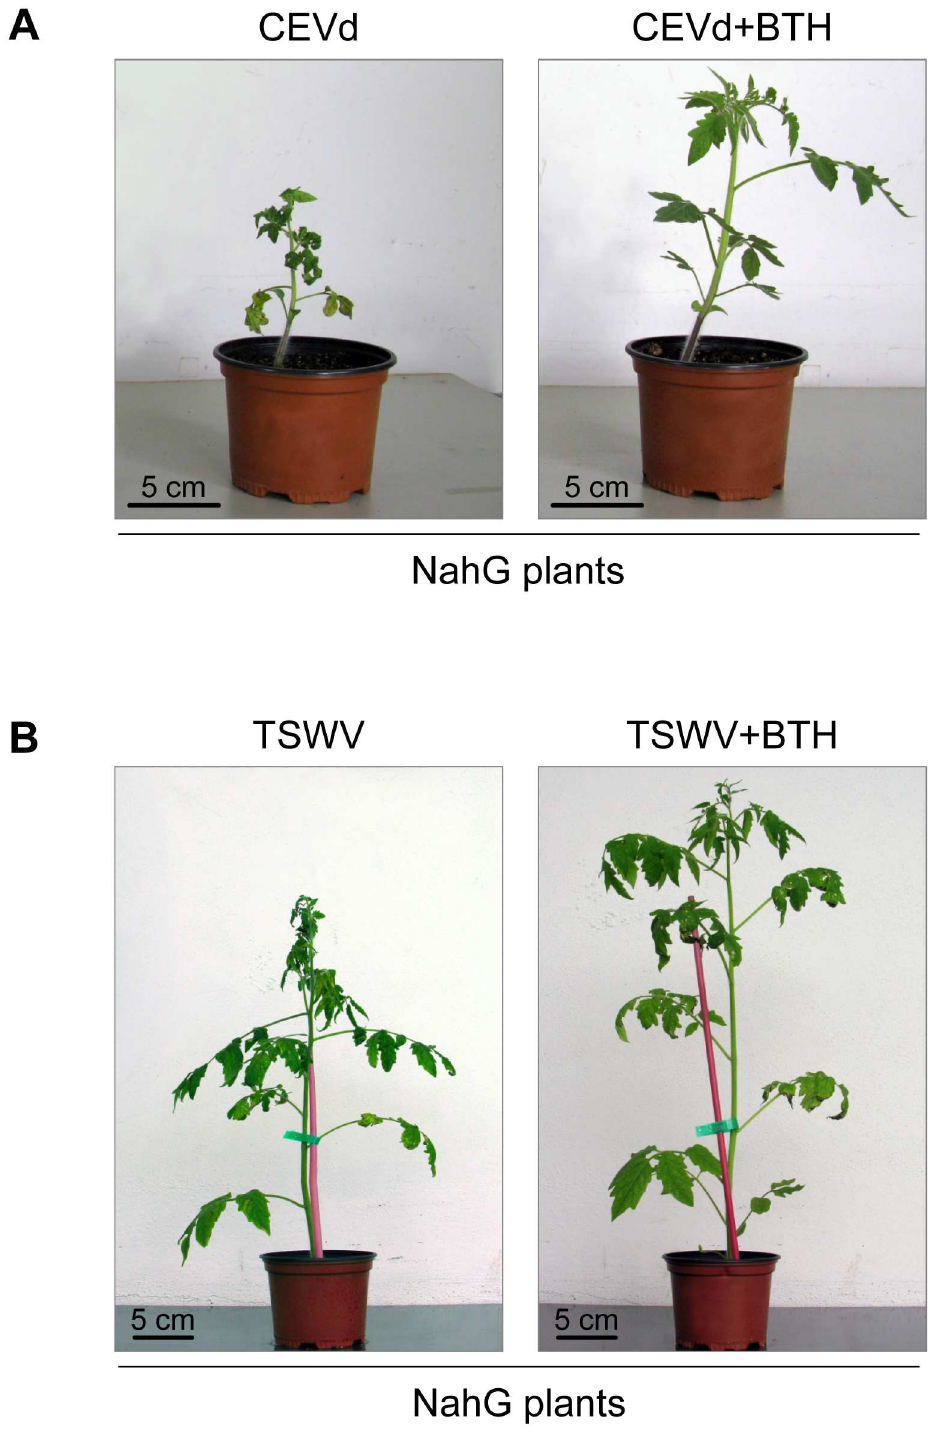
Fig 6. Growth of NahG plants following treatment with BTH and CEVd or TSWV inoculation. A) Representative phenotype observed in infected plants 4 weeks after CEVd inoculation(CEVd), and in equivalent plants that had been pre-treatedwith 1 mM of BTH (CEVd+BTH). B) Representative phenotype observedin TSWV-infected plants 15 days after inoculation (TSWV), and in equivalent plants that had been pre-treatedwith 1 mM of BTH